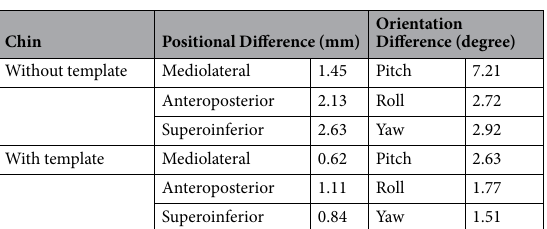
Table 1. Rood mean square deviation (RMSD) of Positional and Orientational Differences between the Planned and Postoperative